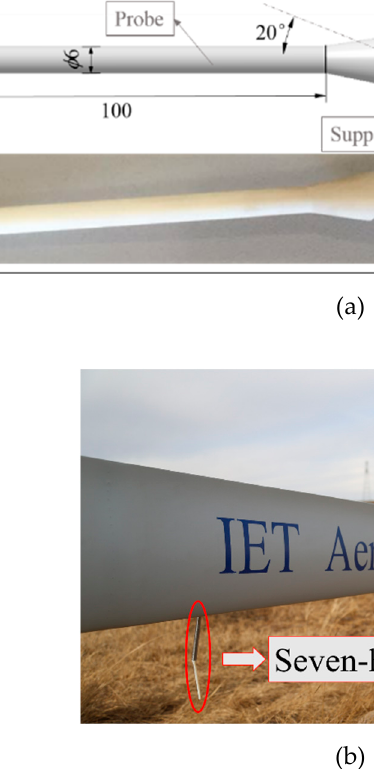
Table 5. Locations of probe